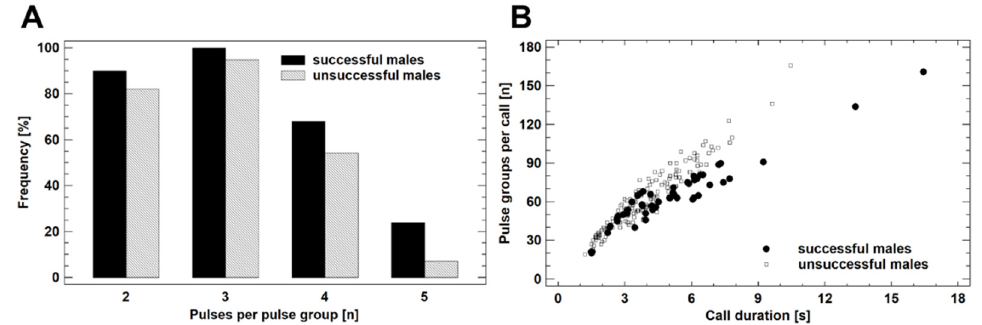
Figure 4. Advertisement call features of breeding R. arenarum . ( A ) Frequency of pulse group types in the advertisement calls (numbers do not add up to 100 because calls included usually more than one pulse group type). ( B ) The most distinctive call variables according to the discriminant analyses. For details see text.